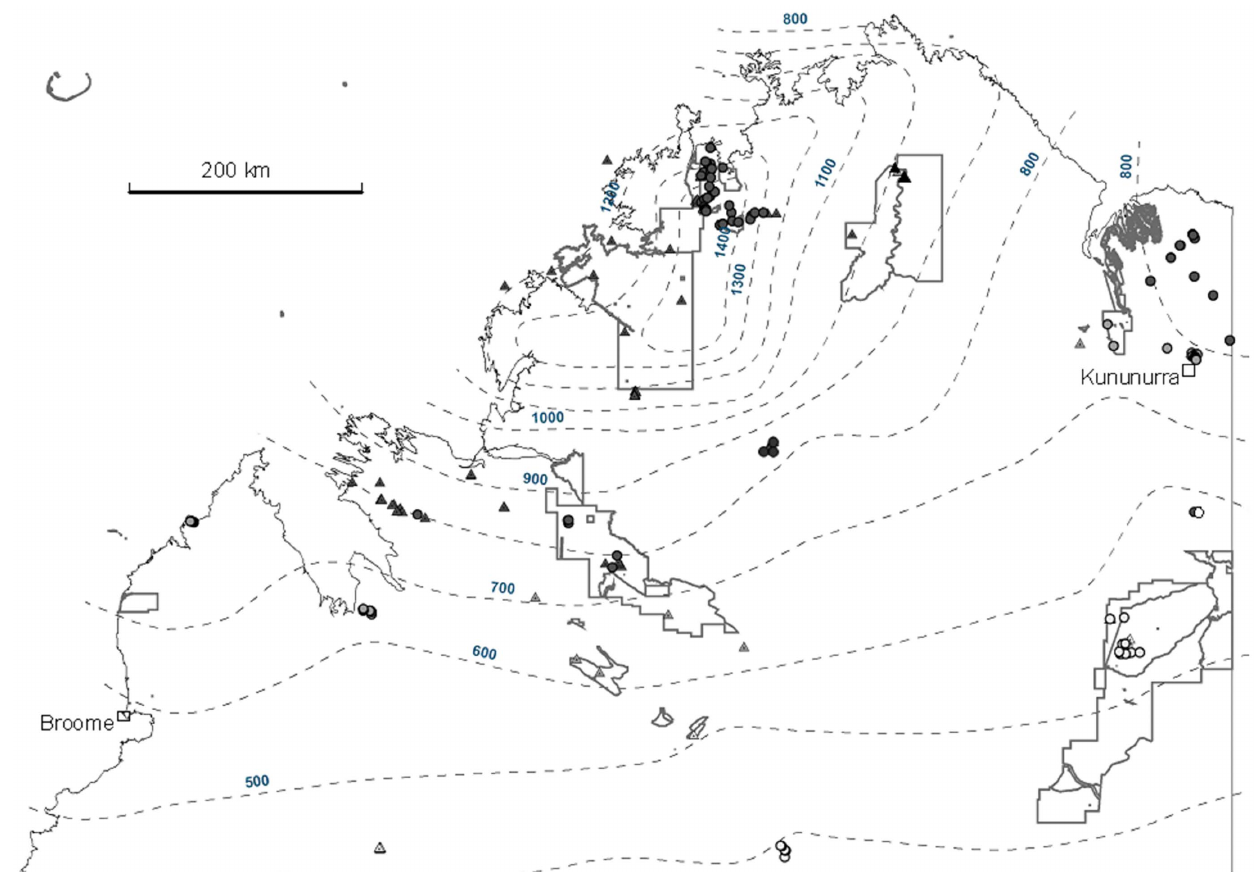
Figure 1. Map showing distribution of Kimberley survey sites with rainfall isohyets (grey dashed lines). Triangles and circles represent surveys in rocky and non-rocky habitats, respectively. Black, grey and pale grey represent high, medium and low rainfall sites respectively. Grey lines are conservation reserve boundaries.